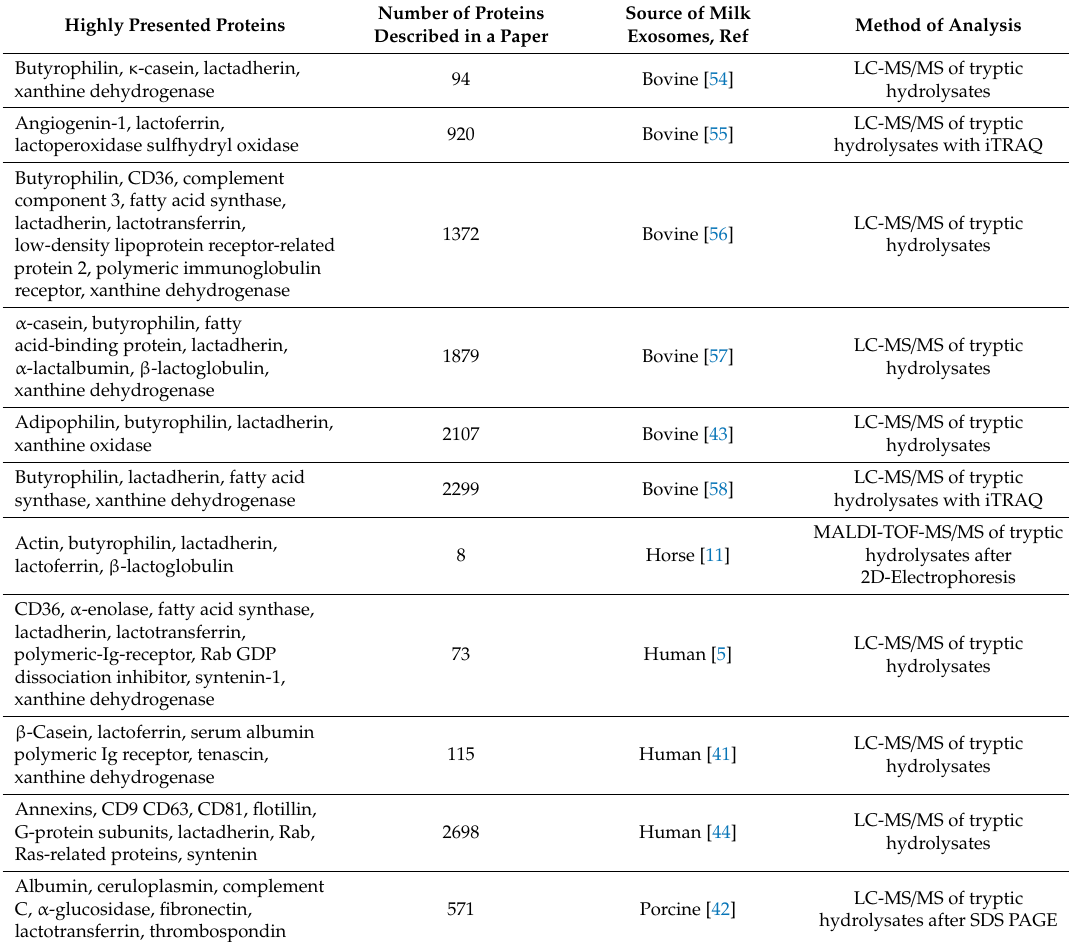
Table 1. Highly represented proteins of milk